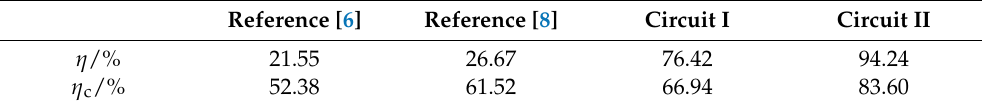
Table 1. Efficiency comparison of nanosecond Marx generators based on avalanche